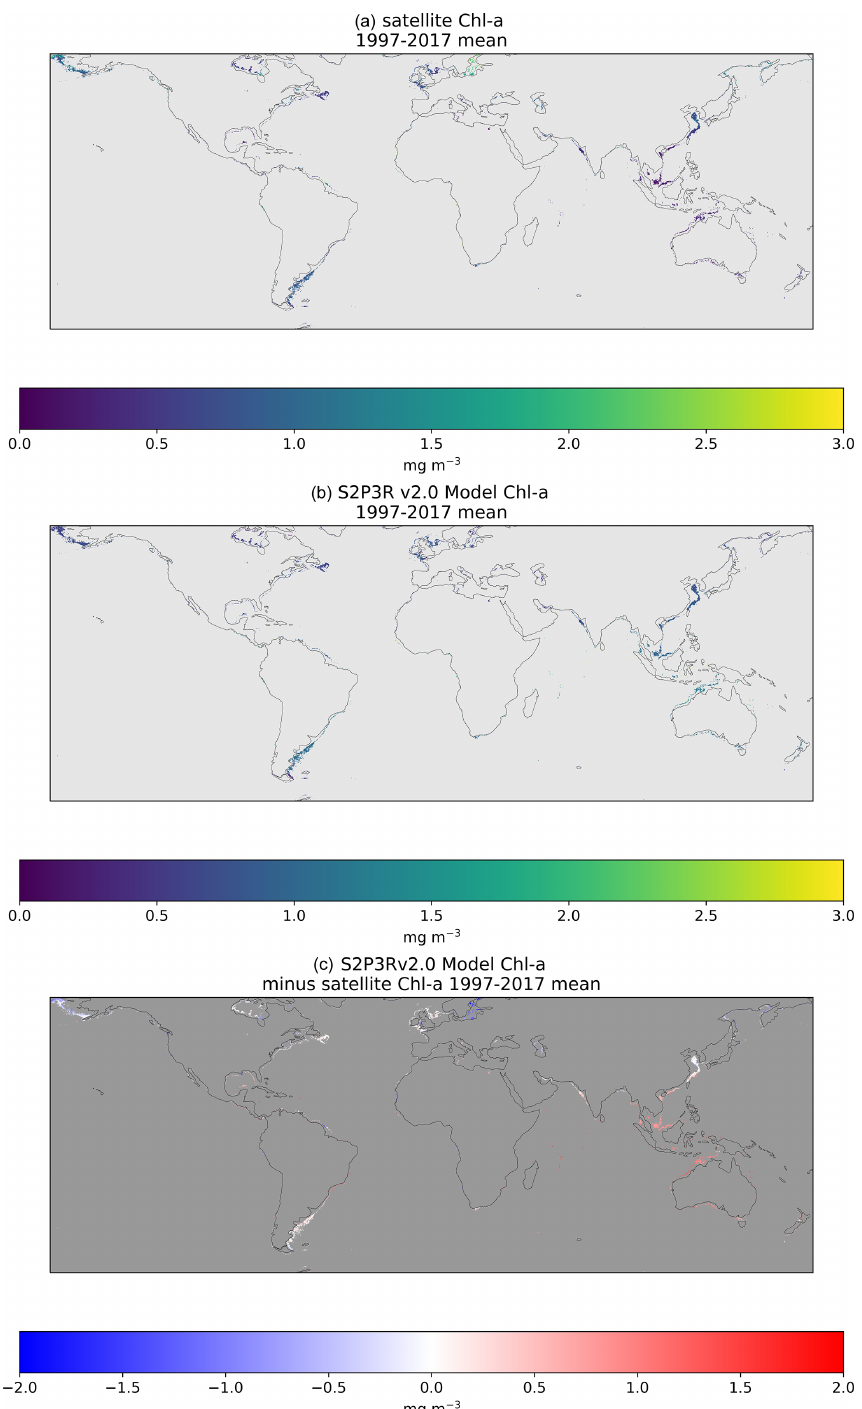
Figure 9. Comparison of surface level chlorophyll- a concentrations with satellite based chlorophyll- a estimates (Sathyendranath et al., 2020). Figures present an annual mean of all data available between 1997 and 2017 inclusive. Satellite data are filtered to include minimised issues associated with case-2 waters by selecting water ≥ 70m water depth. The nutrient data to which the water in the model’s bottom level was relaxed to are taken from the winter values in World Ocean Atlas for each